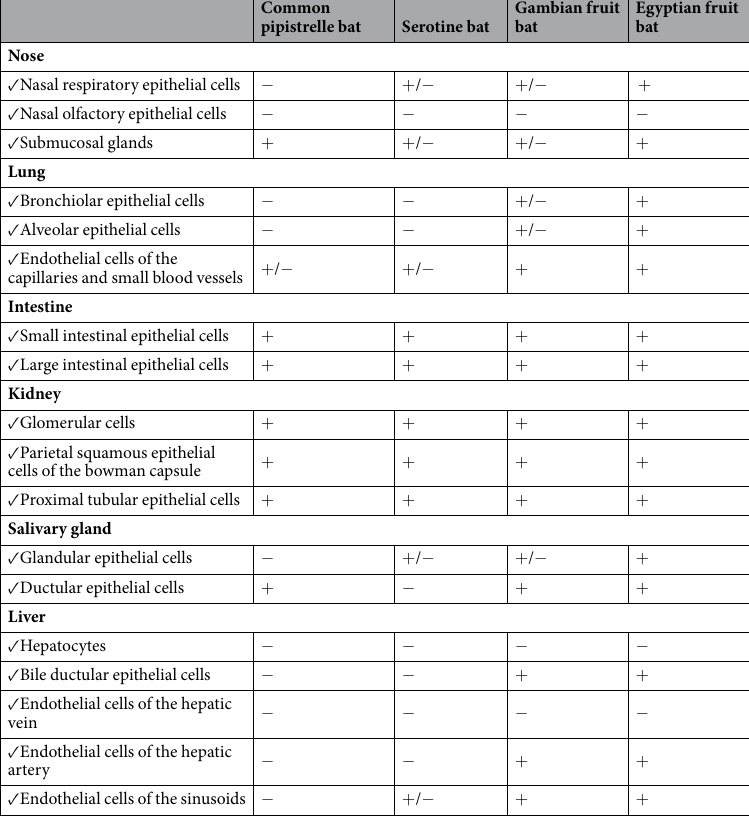
Table 1. Overview of DPP4 expression in the tissues of the common pipistrelle bat, serotine bat, Gambian epauletted fruit bat and Egyptian fruit bat. + , positive detection; + / − , only expressed in a limited number of cells; − , undetected.